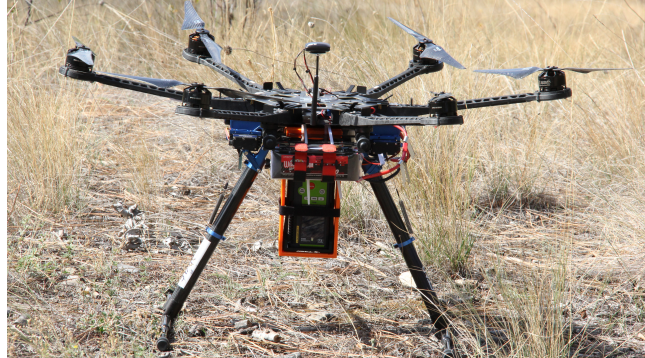
Figure 1. Hexacopter UAV with a laser-based methane detector in the orange box.